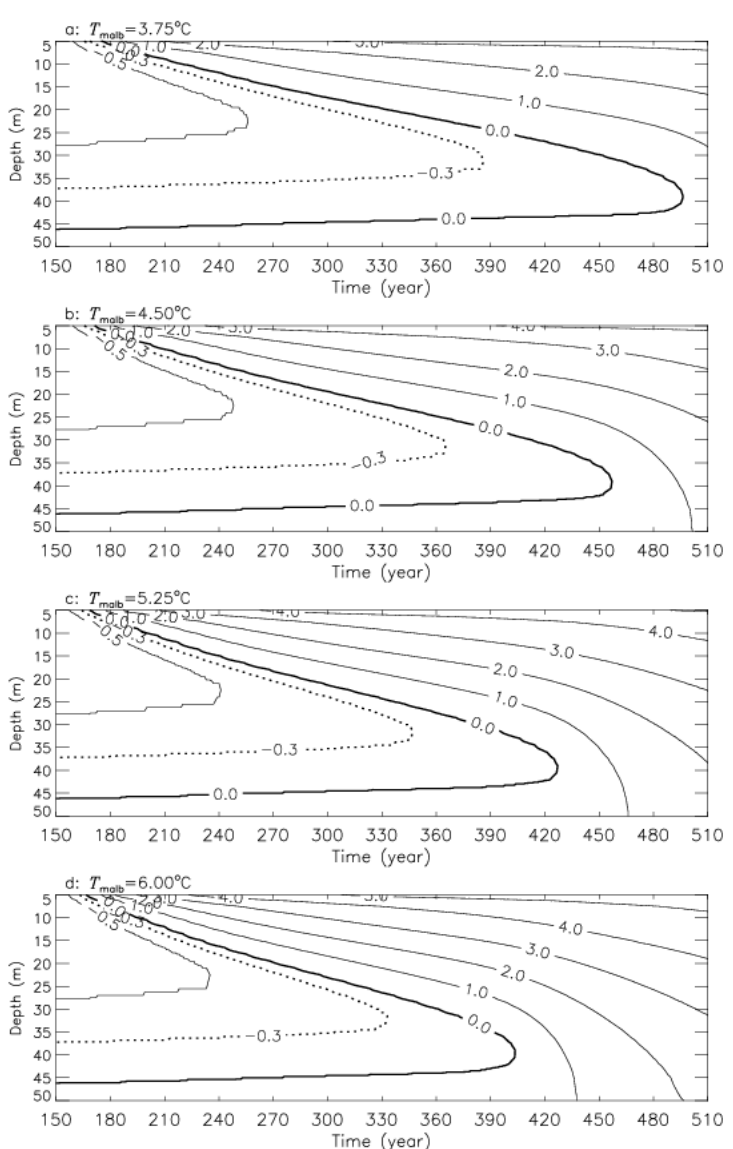
Figure 7. Permafrost degradation processes along r = 45 m nearby the expanding thermokarst lakes with the mean annual lake bottom temperatures (MALBT) of ( a ) 3.75 °C, ( b ) 4.50 °C, ( c ) 5.25 °C, and ( d ) 6.00 °C.